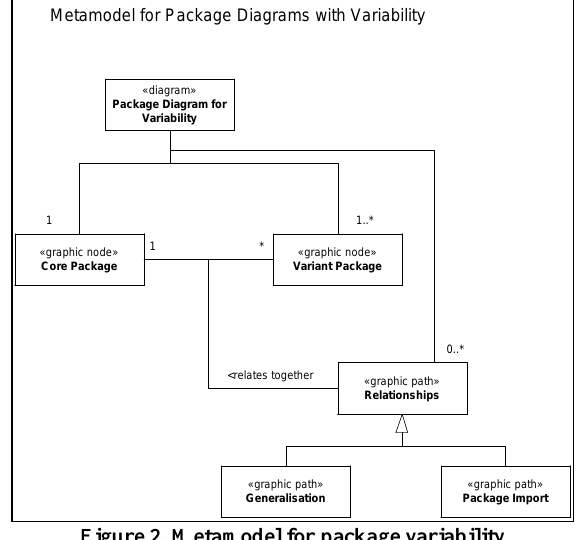
Figure 2. Metamodel for package variability In this metamodel, the two ways of modelling package variability in SysML are depicted. For Case A-mandatory, we propose the use of package import which is standard SysML type of relationship between packages [19]. For Case B – optional, we propose the SysML generalization type of relationship for modelling the “possibility” of including some core functionality to